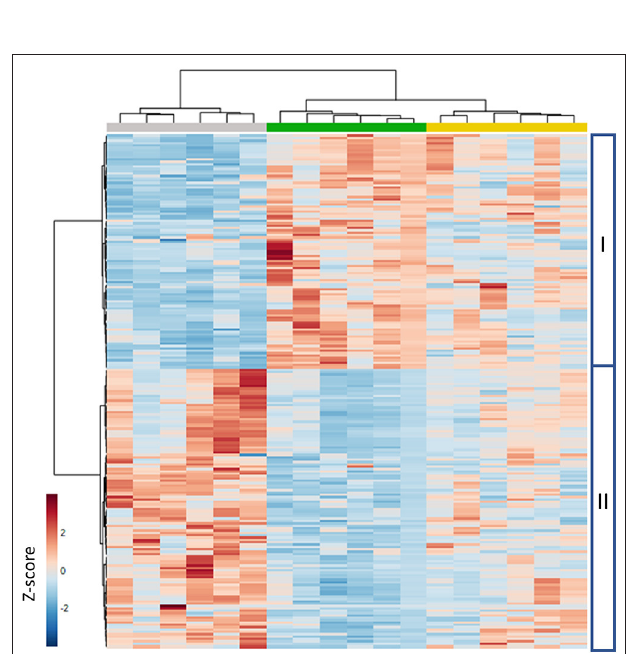
FIGURE 11 | Hierarchical cluster analysis of selected (ANOVA, P < 0.05; fold change > 2) semi-polar metabolites in strawberry leaf metabolomes. A color-coded matrix represents the Z-score of the metabolite intensity in six biological replicates of strawberry leaves. I and II represent clusters of mass features induced (I) or reduced (II) upon MeJA application. Characteristics of the underlying metabolites are presented in Supplementary Table 2 . Gray: mock-treated plants; green: MeJA-treated every 3 weeks; yellow: MeJA treatment upon